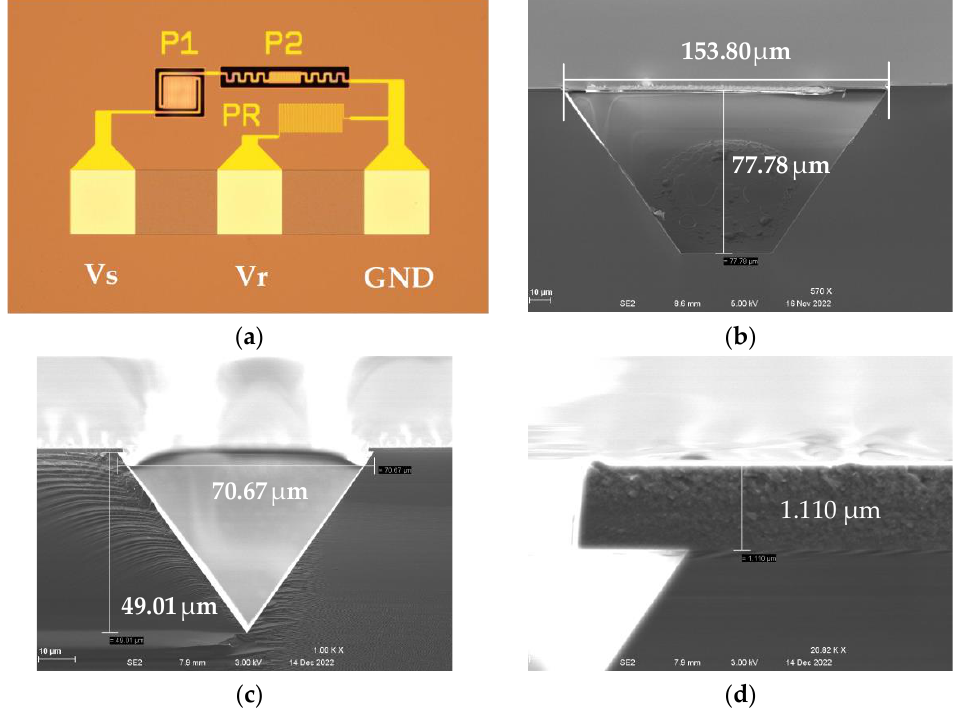
Figure 7. Micrographs of a fabricated MEMS Pirani gauge. ( a ) Top optical microscopic view of the whole device; ( b ) Cross-sectional SEM view of P1 Gauge; ( c ) Cross-sectional SEM view of P2 Gauge; ( d ) Cross-sectional SEM view of the dielectric layer.